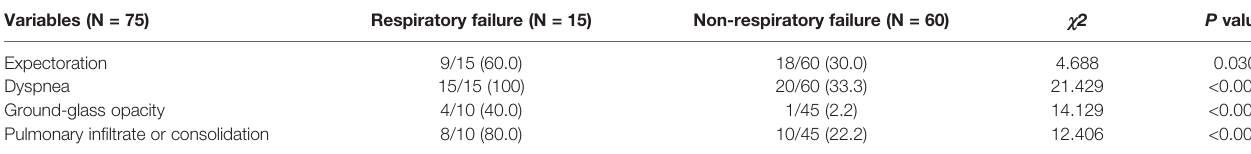
TABLE 6 | Differences between patients with respiratory failure and non-respiratory failure.